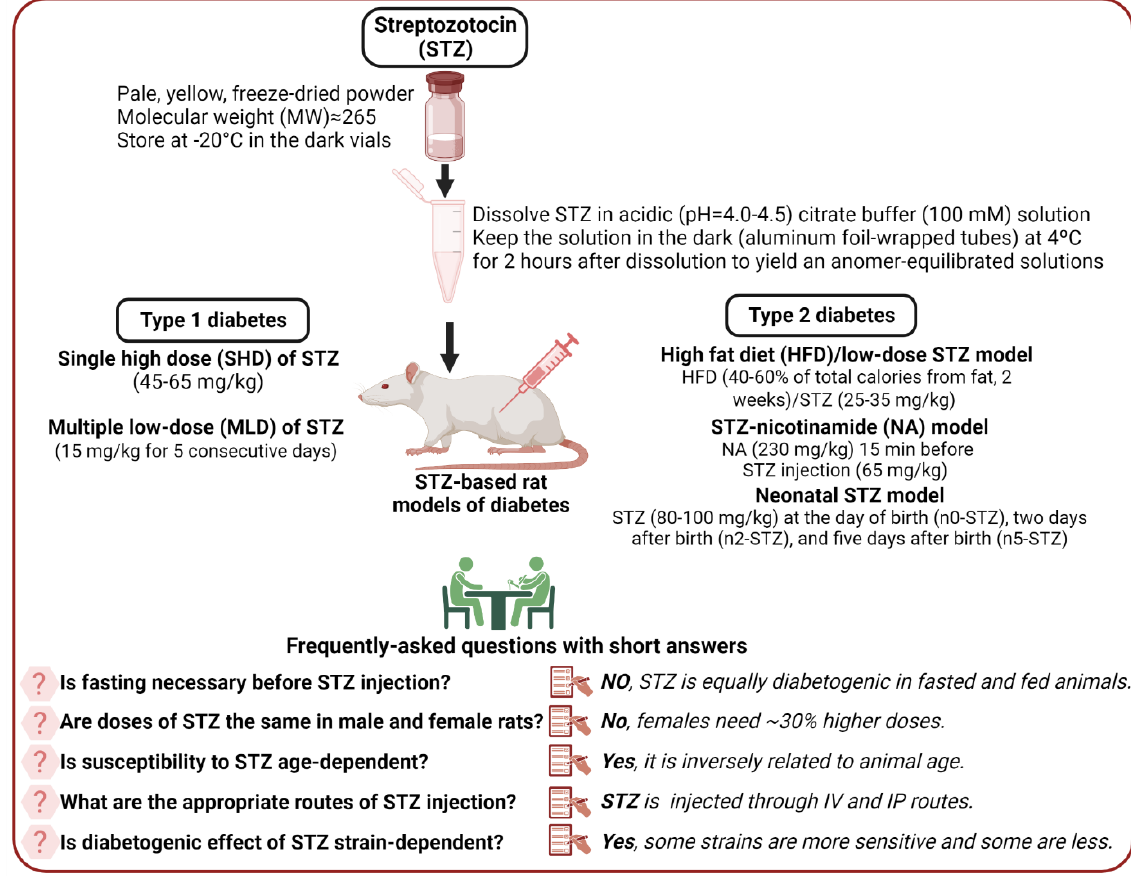
Figure 3: A practical guide for maintaining, preparing, and injecting streptozotocin (STZ) in STZ-based rat models of diabetes. IV, intravenous; IP, intraperitoneal. Created with